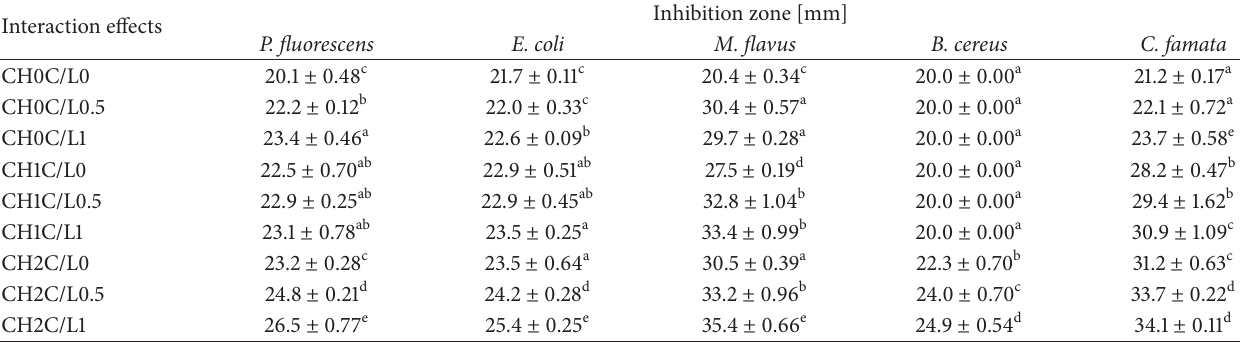
Table 4: Antibacterial activity of edible films modified by CH and C/L preparation (interaction